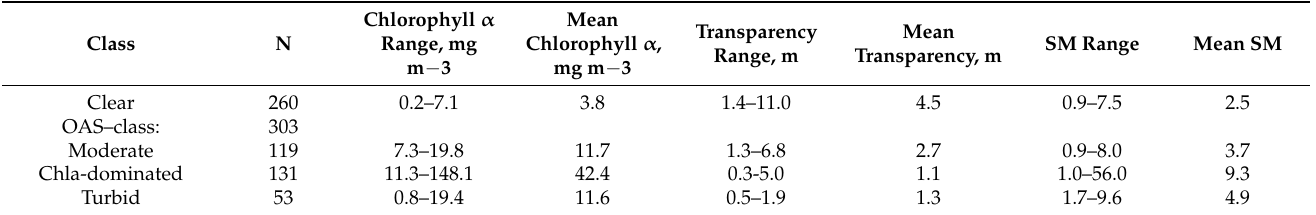
Table 5. Water parameters’ (chlorophyll concentration, transparency, suspended matter (SM)) values of separate classes.